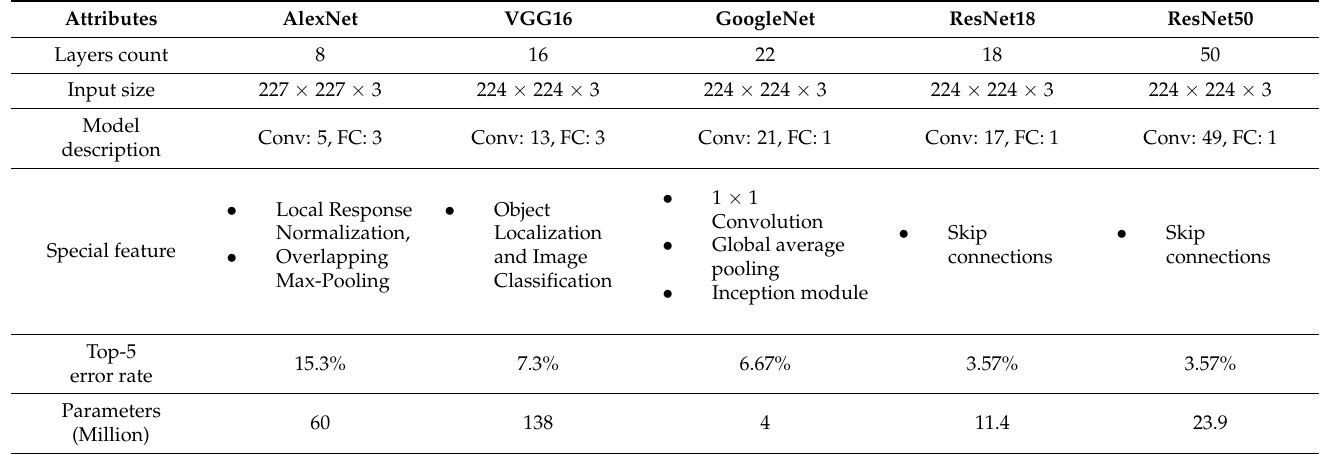
Table 2. Special features of the used pre-trained architecture of